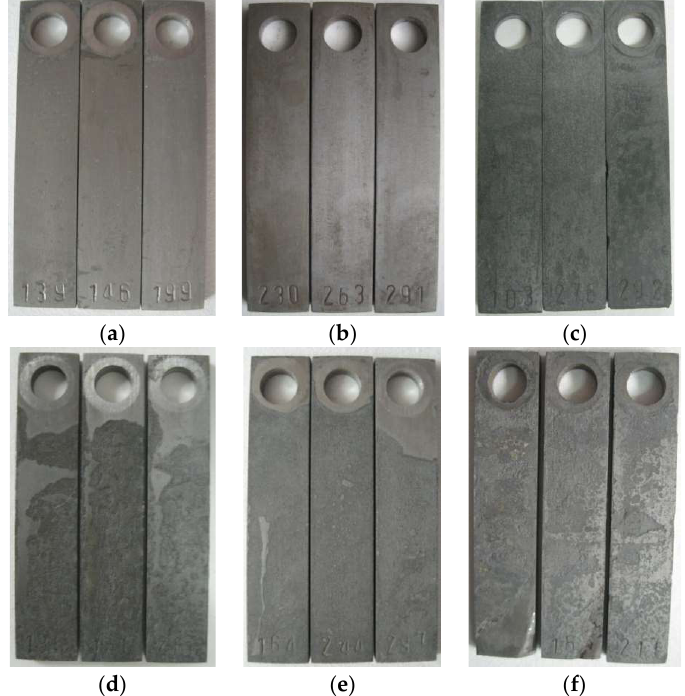
Figure 4. Appearance of samples corroded at the well depths of ( a ) 0, ( b ) 240, ( c ) 580, ( d ) 800, ( e ) 1050, and ( f ) 1500 m after the removal of corrosion scales.